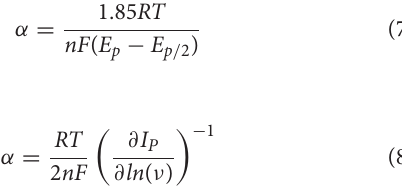
In order to deduce α , Figure 3A : a Tafel plot, Figure 3B : a plot of the peak position versus the logarithm of the scan rate and Figure 3C : the peak shape analysis for the oxidation of vanadyl sulfate at a glassy carbon electrode. The values of the electron transfer coefficient are listed in Table 2